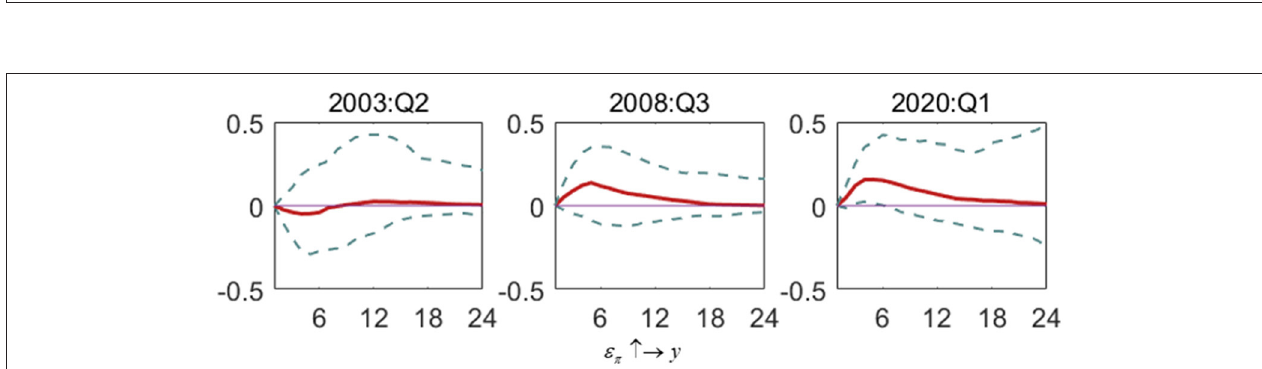
FIGURE 2 | The impulse response of the output gap to interest rate shock in special periods. Each subfigure demonstrates three special periods, including the SARS outbreak period (2003:Q2), the global financial crisis period (2008:Q3) and the COVID-19 outbreak period (2020:Q1). One period in the figure denotes one season.